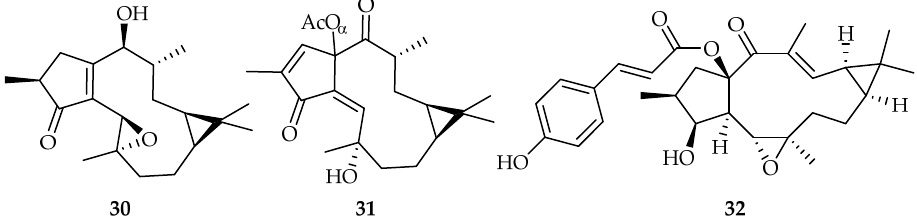
Figure 13. Structures of jatromultone G 30 [23], jatromultone I 31 [23], and euphofischer A 32 [24].